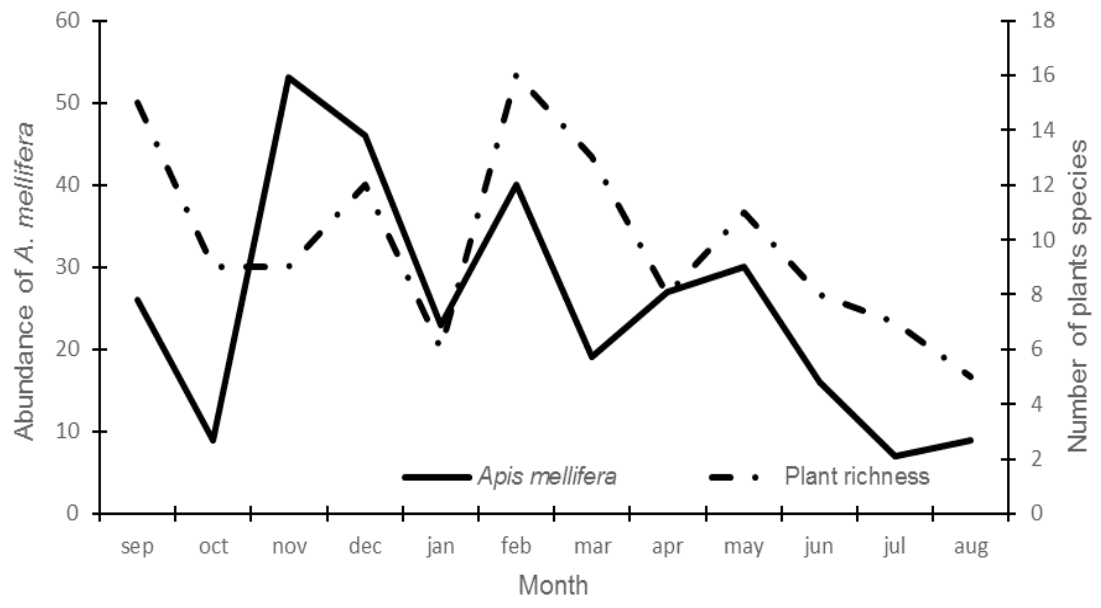
Fig 7 . Floral richness and abundance of Apis mellifera over the